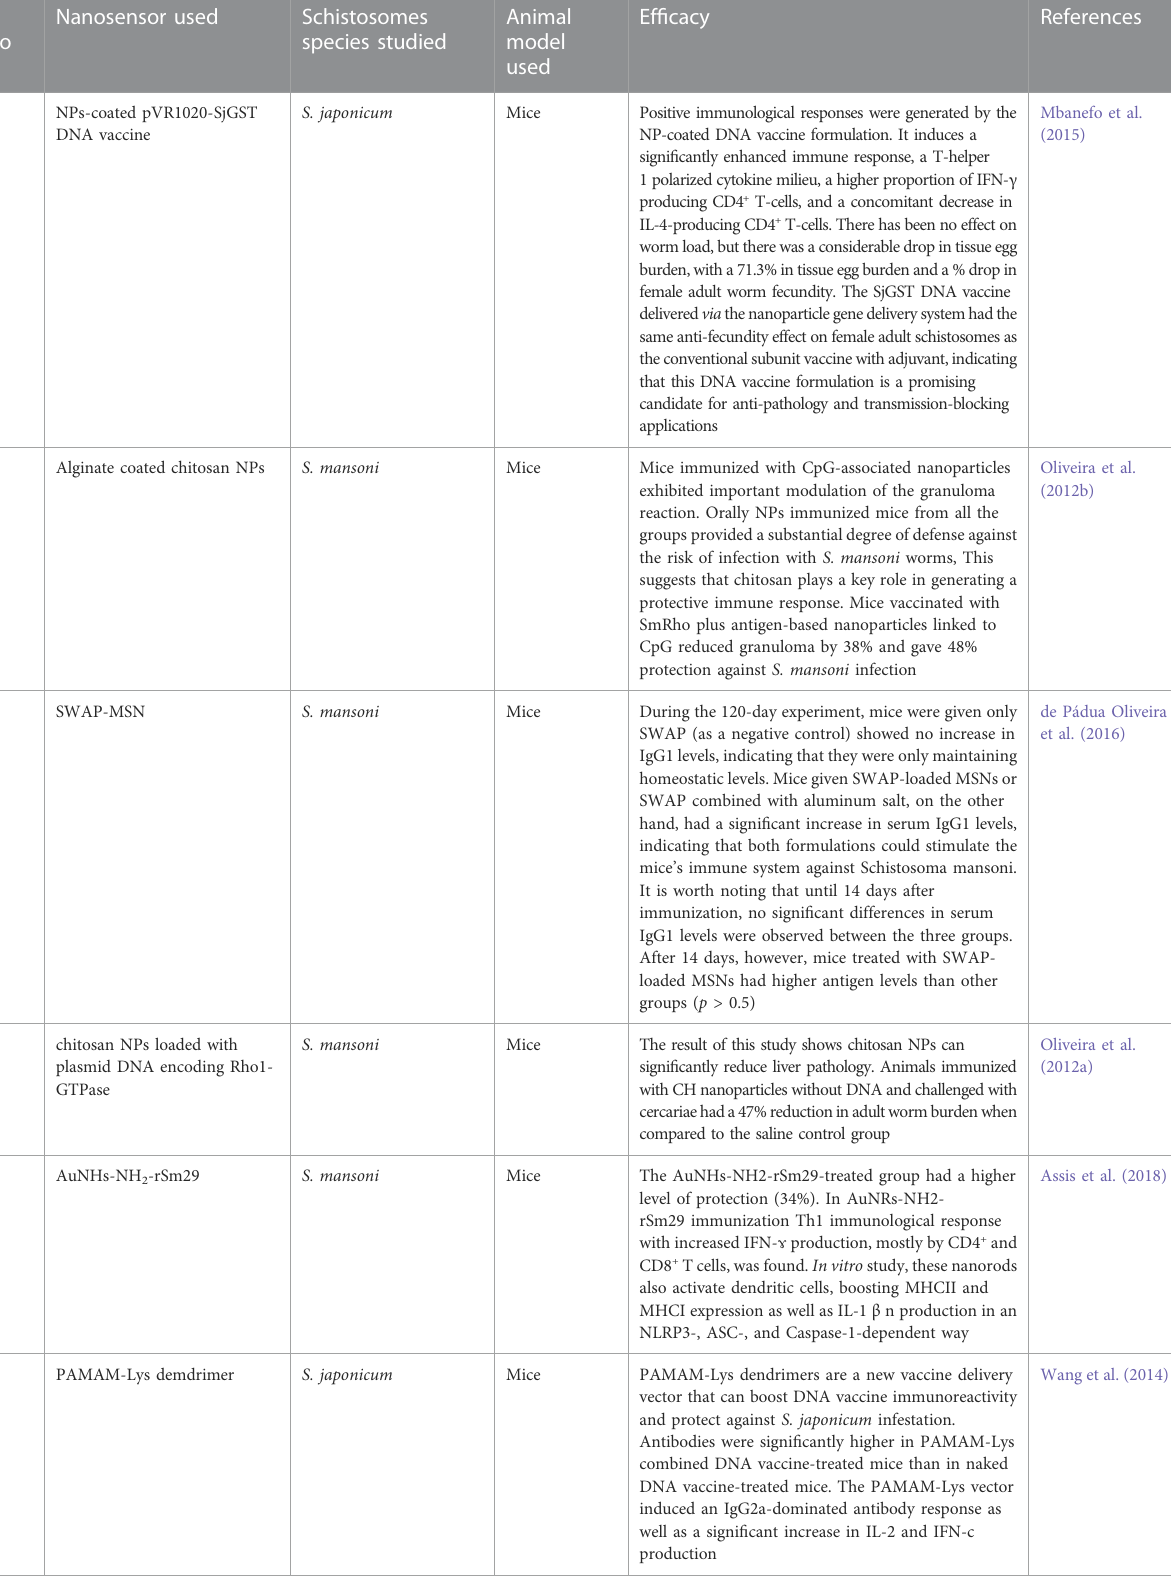
TABLE 4 List of various nanoparticles used along with vaccine materials against schistosomal infections. S.